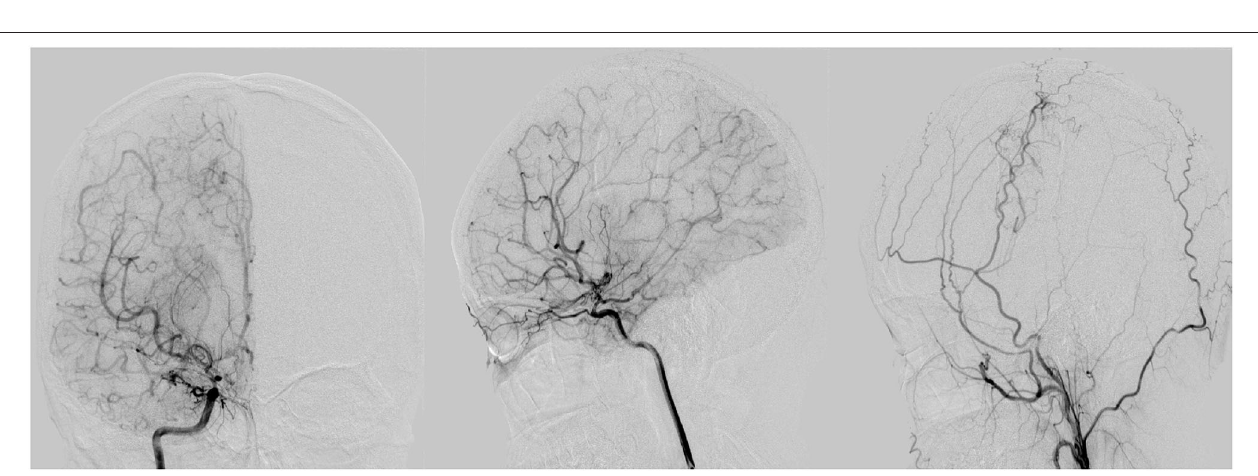
FIGURE 1 | A 31 years old female with G/A genotype showed seriously ischemic situation with a poor collateral status (stage I) pre-operatively and surgical collateral circulation showed grade A 3 months after encephaloduroarteriosynangiosis (EDAS) procedure. The three illustrations of digital subtraction angiography (DSA) from left to right are the front view of right internal carotid artery (ICA), the vertical view of right ICA, the vertical view of right external carotid artery (ECA) 3 months after EDAS.